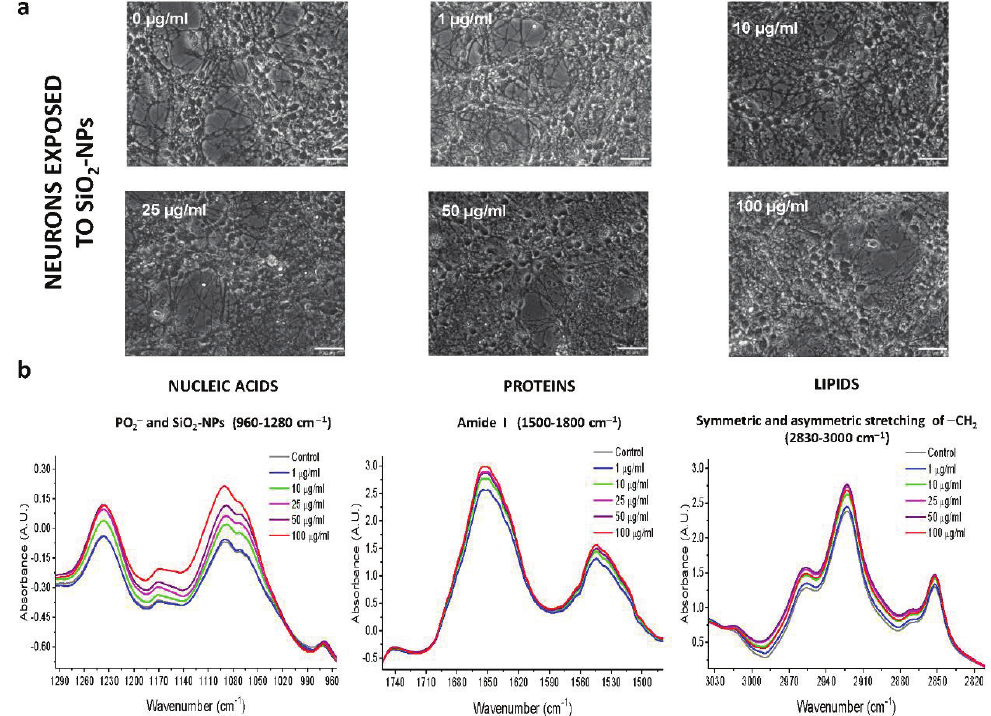
Figure 3. Morphological changes and normalized IR spectra of the primary cultures of neurons exposed to SiO 2 -NPs. ( a ) Neuron morphology after 24 h of SiO 2 -NPs exposure. Images were obtained by light microscopy. Each treatment was performed at least in triplicate ( n = 3) with three technical replicates. There are no morphological changes in the concentrations of 0–25 µ g / mL, but at 50 and 100 µ g / mL, there are clear morphological changes such as a reduced cell volume and a decrease in the amount of cells. Scale bar: 150 µ m. ( b ) Normalized IR spectra of neurons exposed to SiO 2 -NPs. The spectral region of 960–1280 cm − 1 corresponds to PO 2 - (nucleic acids) and SiO 2 -NPs, 1500–1800 cm − 1 to spectral region that contains the amide I spectral bands and representative bands of the secondary protein structure, and 2830–3000 cm − 1 includes the spectral bands of symmetric lipid CH 2 and asymmetric CH 2 . The spectral images are representative of four independent experiments performed with each treatment, with three technical replicates.